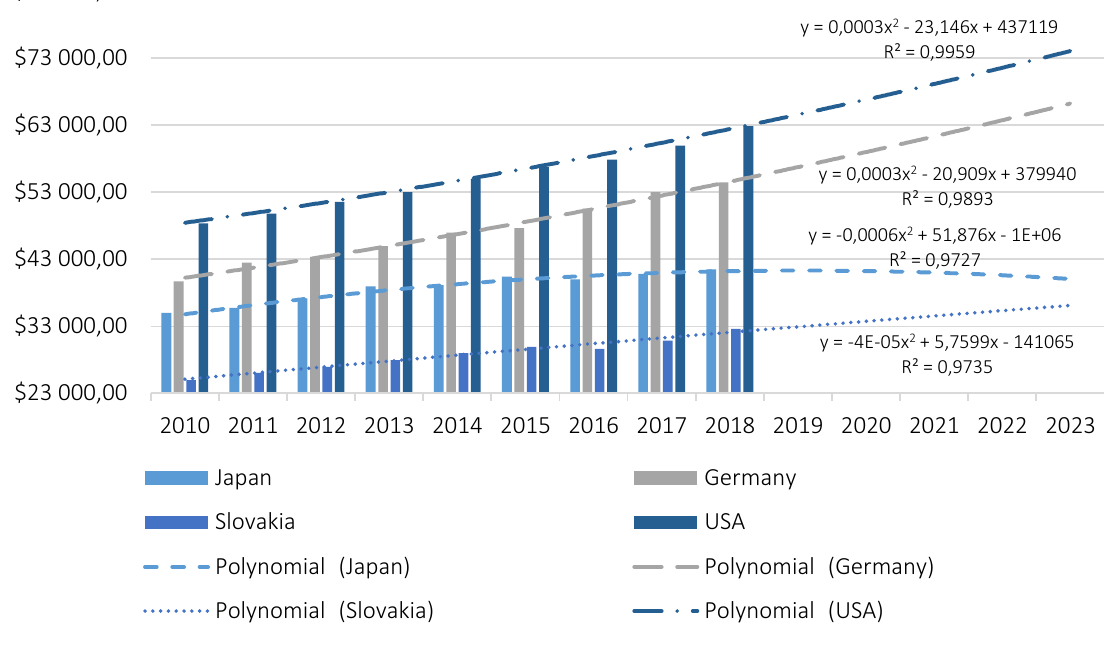
Figure 6. Labor productivity per capita in the countries being